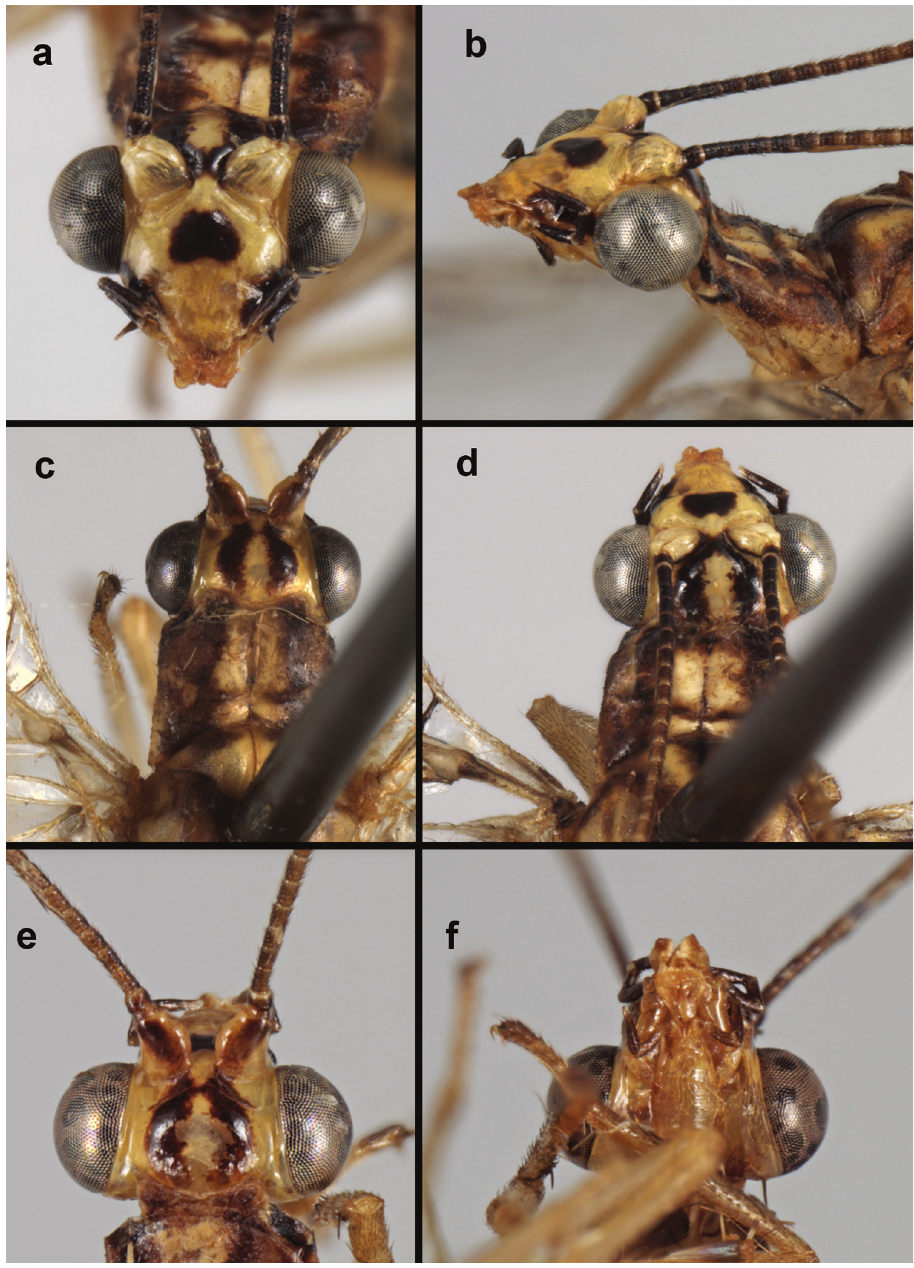
Figure 78. Ungla quchapampa Tauber, sp. n. External features, ( a ) head, frontal ( b ) head, prothorax, lateral ( c ) head, prothorax, dorsal ( d ) head, thorax, dorsal ( e ) head, dorsal ( f ) head, ventral (Bolivia, Cochabamba, paratypes, male,